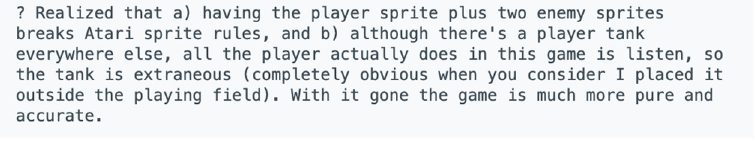
Figure 7. Design documentation from the moment of removing the player tank in The Conversation . Commit c993d80.